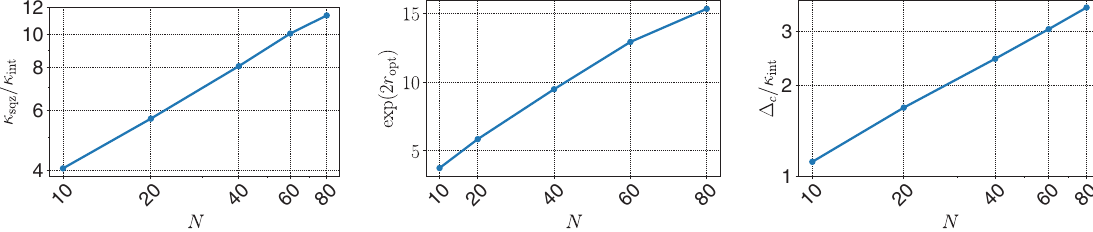
FIG. 15. Values of optimal parameters obtained from master equation simulations of both the dissipative as well as the OAT protocol, which are used to generate Fig. 5 of the main text. Left and center panels show the optimal values of κ result from the dissipative protocol simulations. The right panel shows the optimal spin-cavity detuning that is used in for the OAT protocol. See Fig. 5 for details about the rest of the parameters that we